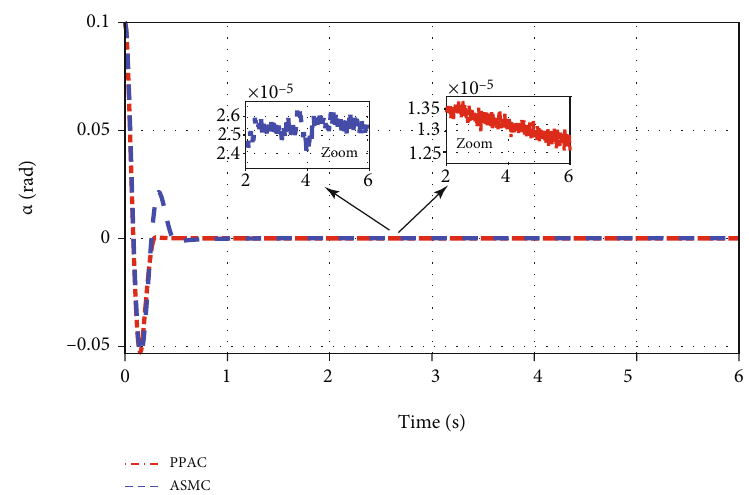
Figure 7: α responses of the closed-loop system with Case